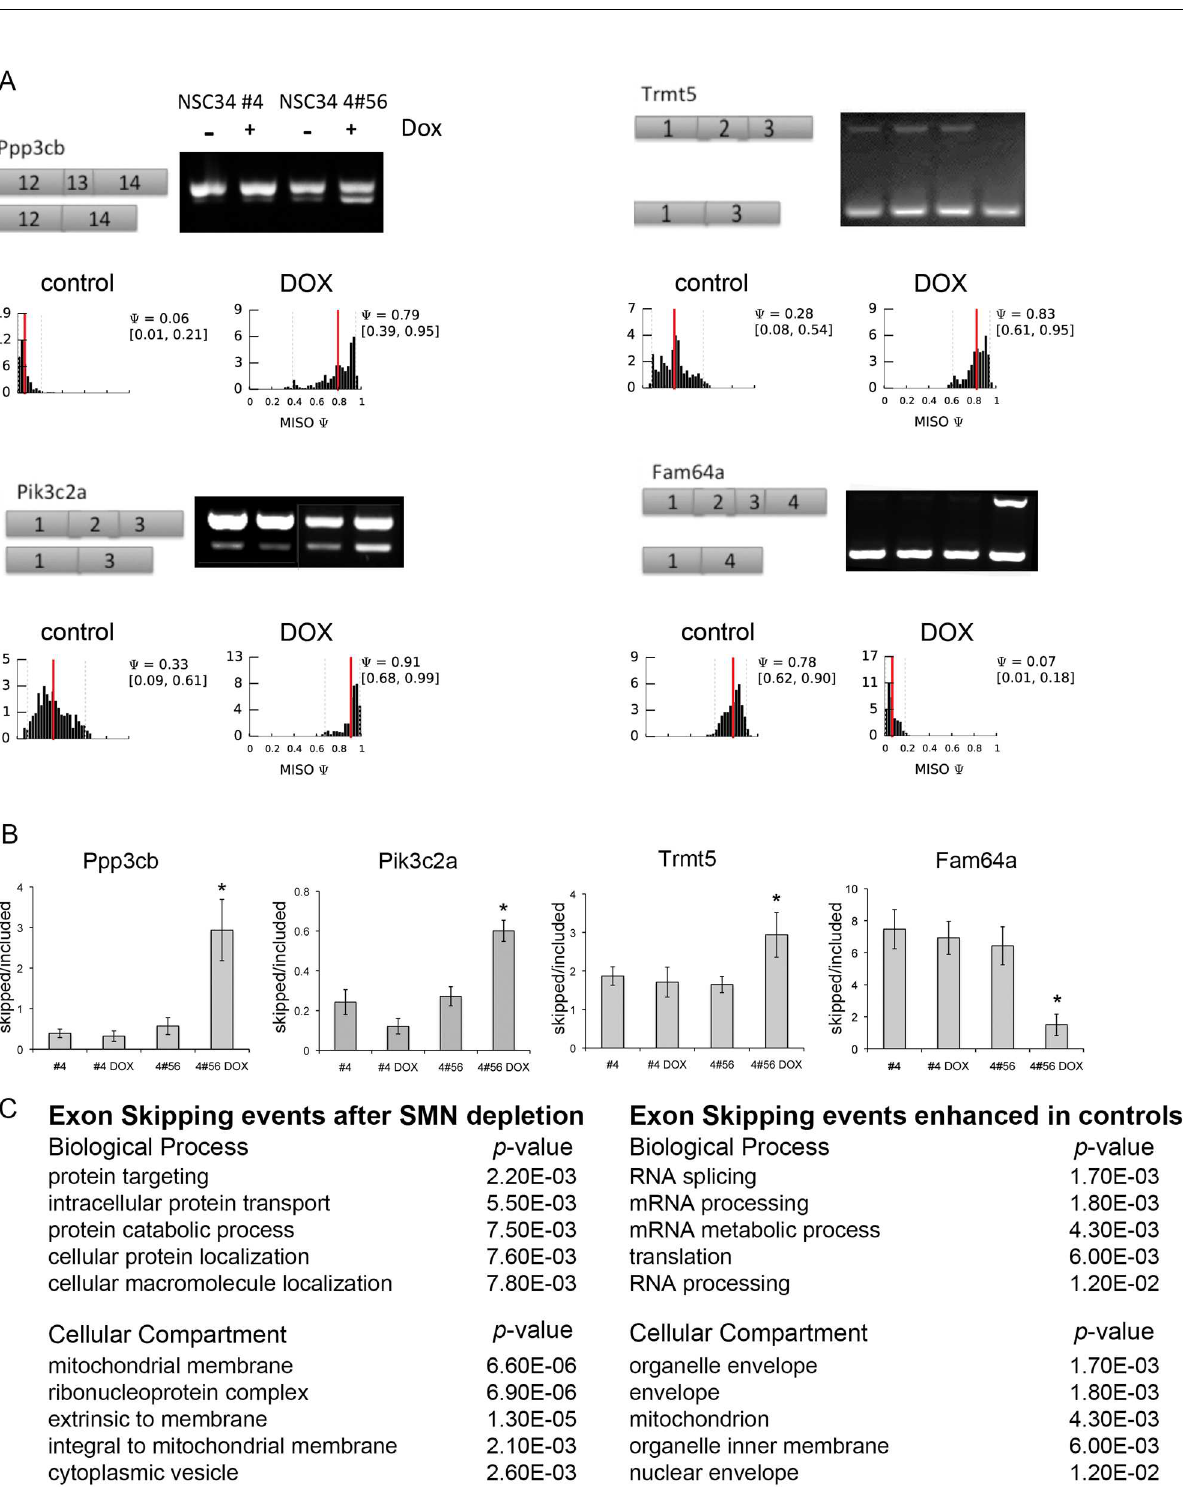
Fig 2. SMN depletion results in alternative exon splicing. A) RT-PCR documented alternative splicing events followingSMN depletion for three group 1 and one group 2 transcripts. The histograms show the posterior distributions over PSI estimated by MISO in control or SMN-depleted samples conditions. The red lines depict the posterior mean and the dotted grey lines indicate 95% confidence intervals (also shown in parenthesis). B) Quantification of RT-PCR band intensity from 3 biologicalreplicates showed increasedalternative splicing after SMN depletionbut not after doxycycline treatment of NSC-34-4. C) Gene Ontology results for exon skippingevents and exon retention events induced by SMN depletion. * – p < 0.01.One-way ANOVA followedby post-hoc t-test.